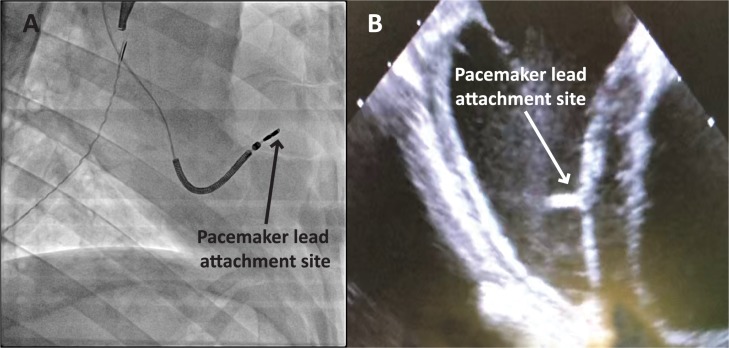
Representative fluoroscopy and ICE confirm attachment site of ventricular leads at the RV septal wall.(A) Fluoroscopic image showing the ventricular lead attached at the RV septal wall. (B) ICE recording confirming the ventricular lead attached at the RV septal wall.